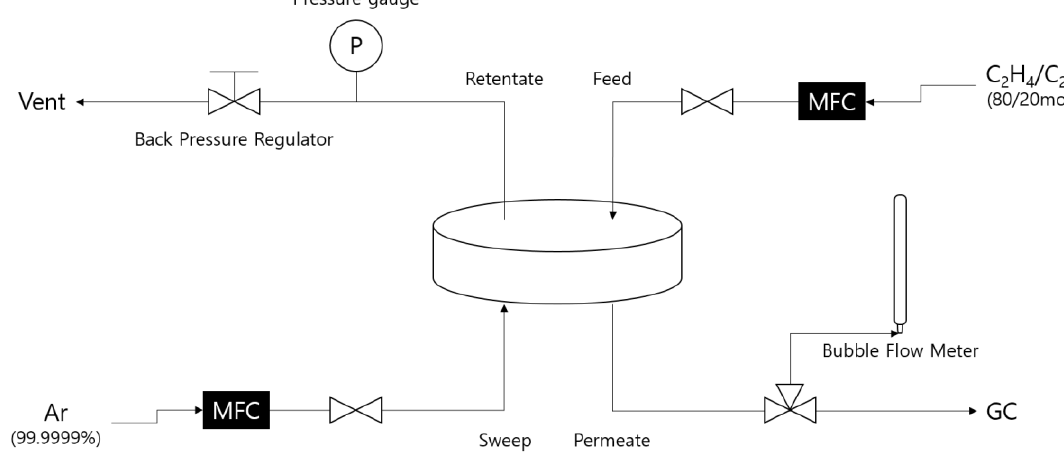
Figure 2. Gas permeation test setup .